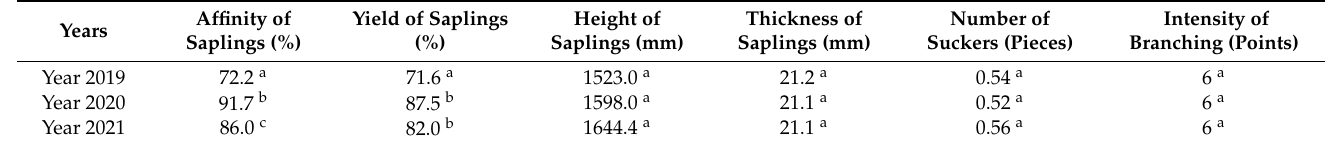
Table 4. Average trait values in individual years and statistical